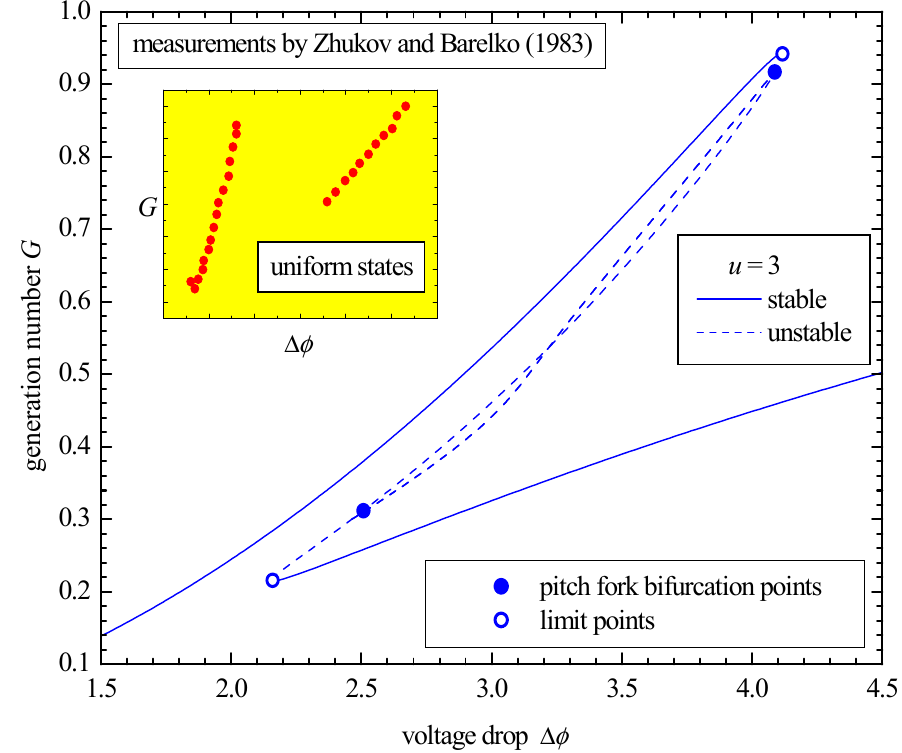
Figure 8. Terminal characteristics for 𝑖 = const and 𝑢 = 3 .